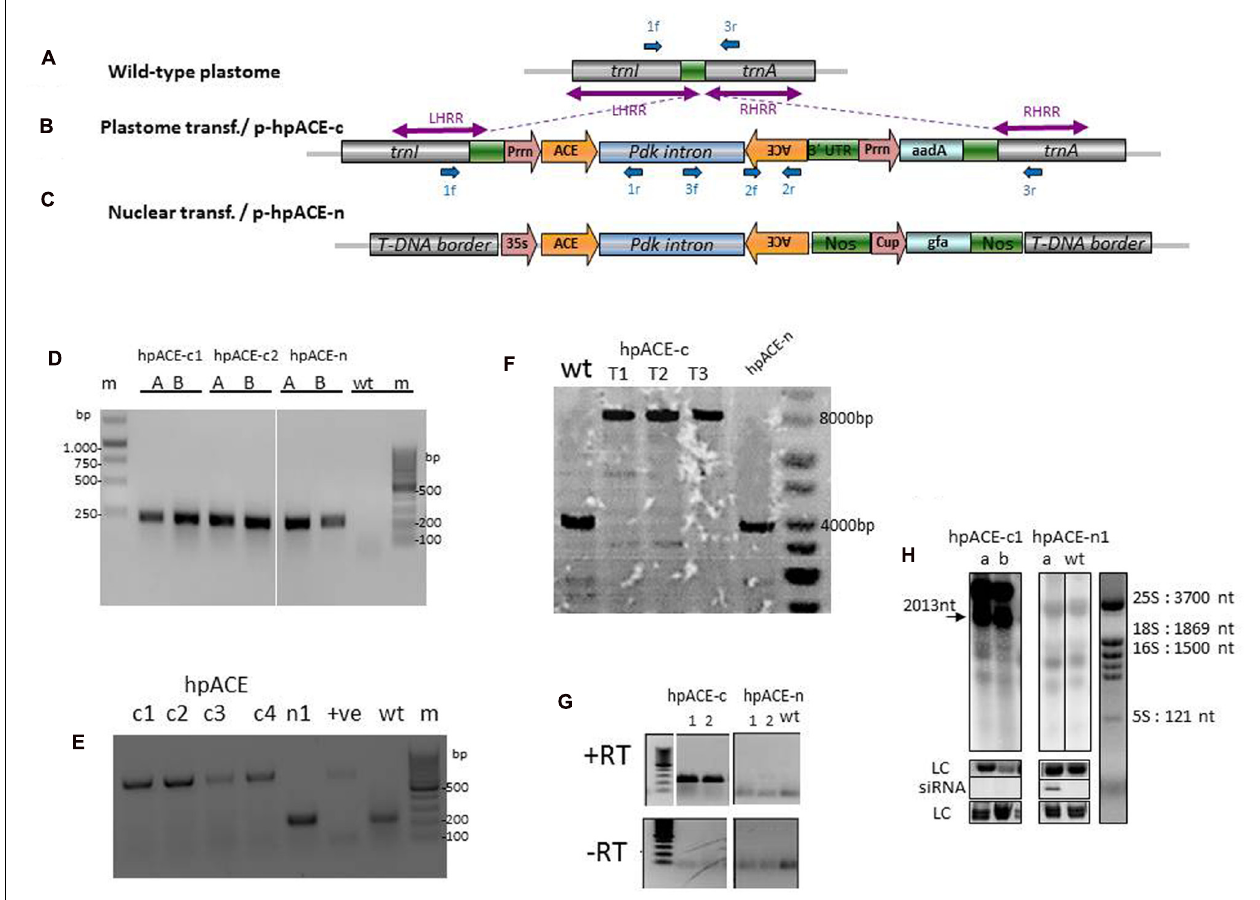
FIGURE 3 | Acetylcholinesterase hairpin dsRNA construct and evaluation of transgene integration in the plastid genome. Targeted plastid genome region (A) and recombinant tobacco plastome (B) after recombination with transforming vector p-hpACE-c and transgene integration. aadA , spectinomycin resistance gene; Prrn , tobacco 16SrDNA promoter; PsbA , tobacco psbA promoter; rbcL , Rubisco large subunit. LHRR and RHRR are the left and right plastid recombination regions present in the transforming vector. (C) Nuclear transformation vector. Forward (f) and reverse (r) primers used for PCR and RT-PCR analysis are indicated by blue arrows. (D) PCR analysis of transformed lines showing hairpin arm amplification using the primer pair 2f/2f and the integration location (E) using primer pairs 1f/1r or 1f/3r. (F) Southern blot showing the homoplasmy for the first, second, and third generation of transformed lines. (G) Reverse transcription (RT) assays and Northern blot (H) of RNA samples extracted from hpACE-c and hpACE-n transformed and untransformed N. benthamiana plants. LC; loading